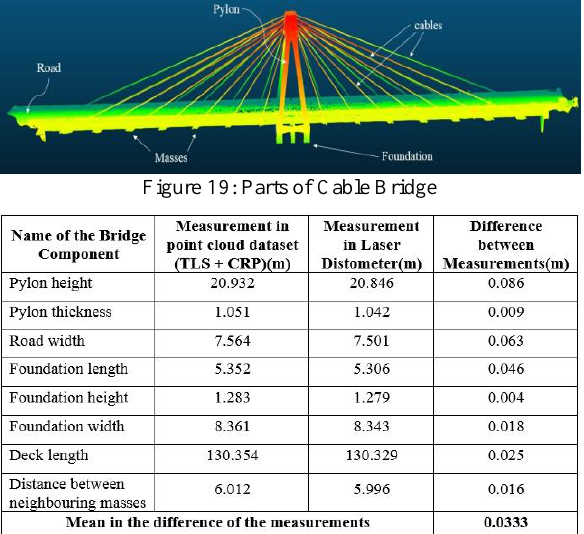
Figure 18: Bottom drawing of Cable Bridge Some parts of the Cable Bridge are shown in the figure 19.